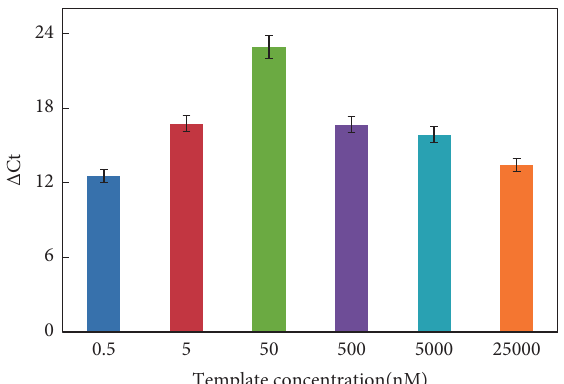
Figure 3: △ Ct value vs the amount of template concentration. Experiment conditions: miRNA was 1nM; forward primer was 4 μ M; reverse primer was 2 μ M; and Tm was 42 ° C. The detection procedure was carried out as described in the experiment section.